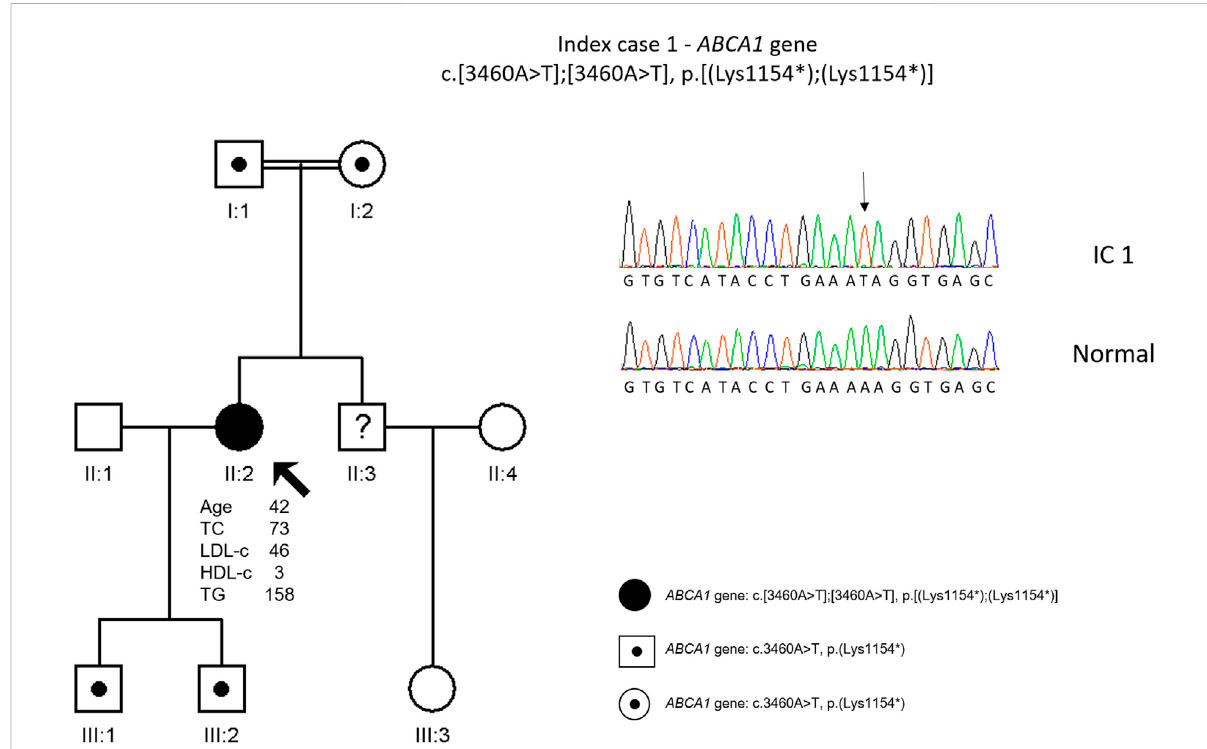
FIGURE 1 Arrow indicates index case 1 (IC1). Age (in years) and lipid pro fi le in mg/dL are under each symbol. Point symbols represent heterozygous individuals for the variant in ABCA1 gene, c.3460A > T, p.(Lys1154*). Black fi lled symbol represents homozygosity for this variant (c.3460A > T, p.(Lys1154*)). Partial sequence of ABCA1 gene of IC1 and a normal